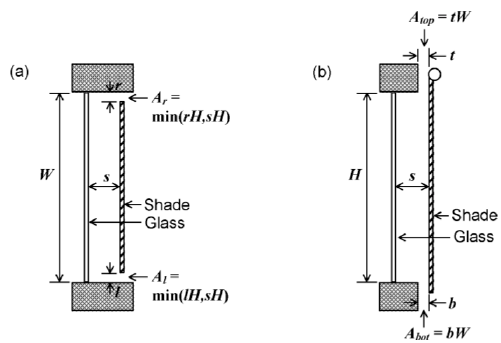
Figure 2. Window shade examples. First shade from the view from the top ( a ) and second shade view from the side ( b ).